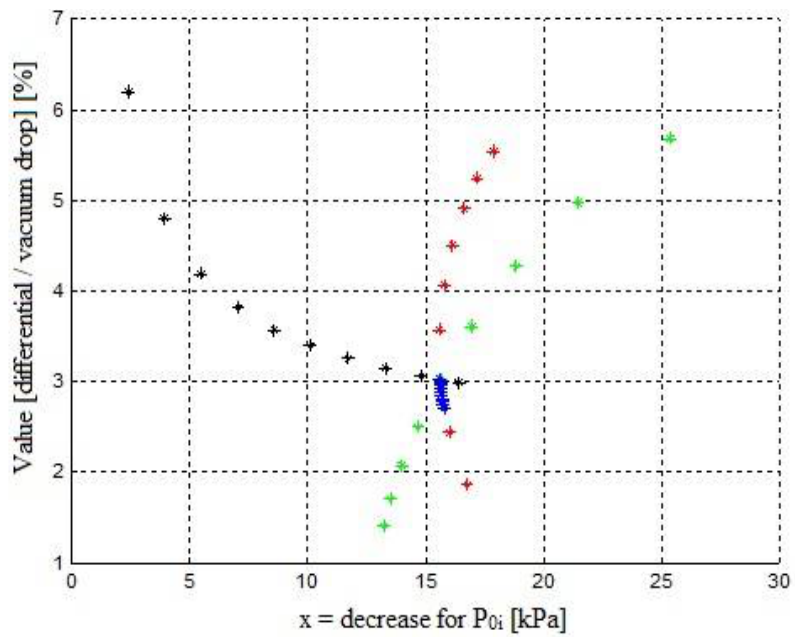
Figure 5. Relative value of the differential, calculated at points ([ P 0i , ∆ P 0i )), where: ∆ P 0i = (0, 0, 0, 0, 0, 0, 0.003, 0.003, 0.05).